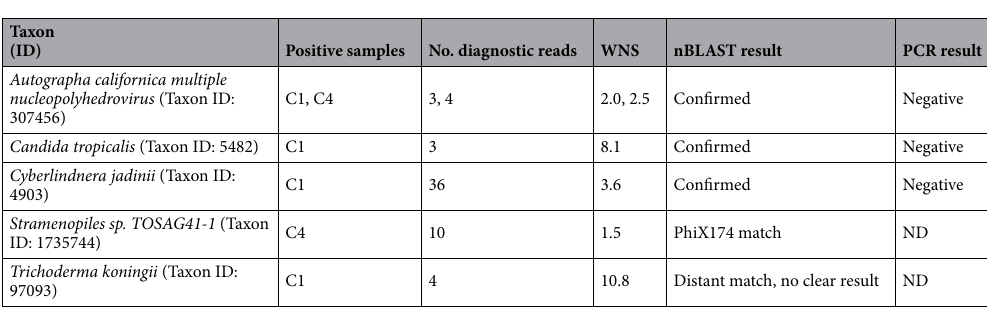
Table 3. Positive bioinformatic hits from amniotic fluid. WNS water normalization score, ND not done.